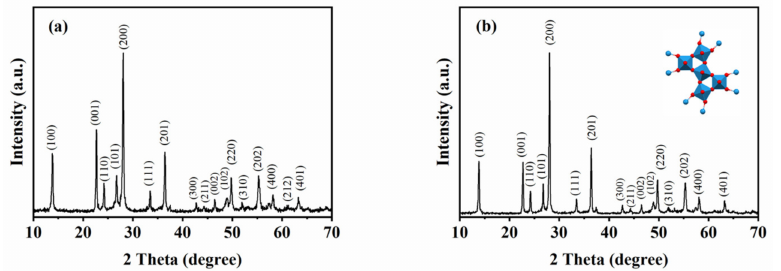
Figure 2. XRD patterns of the formed products with different initial reactants. ( a ) 1.4432 g Na 2 WO 4 2H 2 O, 30 mL 0.25 mol L − 1 H 2 SO 4 ( b ) 1.4432 g Na 2 WO 4 2H 2 O, 20 mL 0.375 mol L − 1 H 2 SO 4 , and 10 mL glycerol.